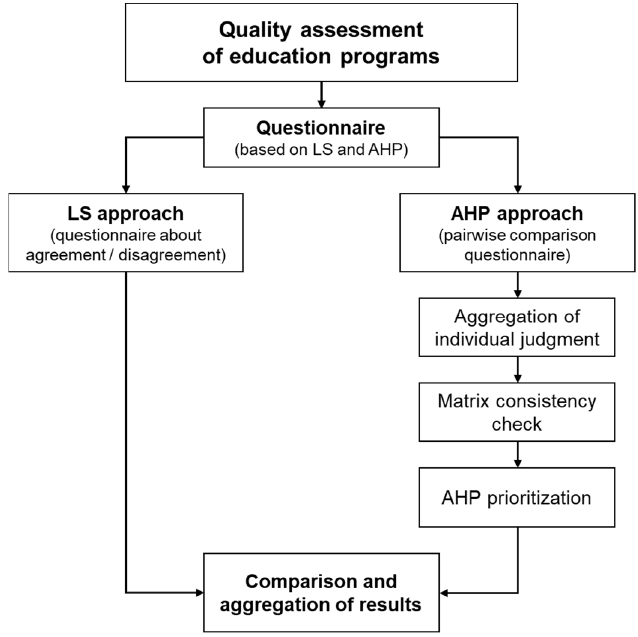
Figure 3. Proposed methodological approach for the quality assessment of education programs. Table 2. Definition of the hierarchy of dominance according to the